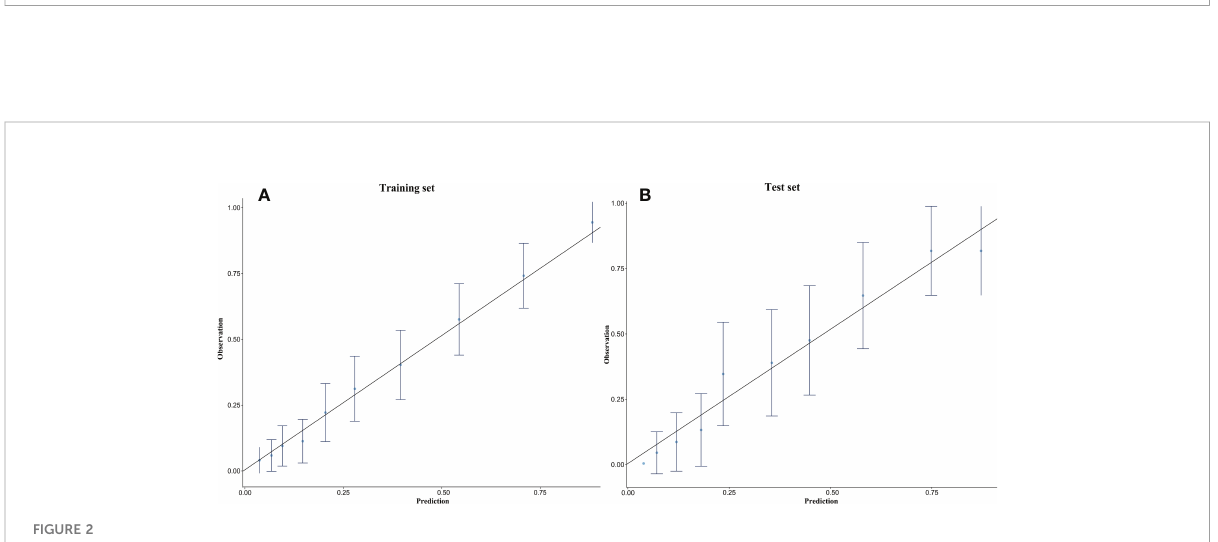
FIGURE 2 Calibration curves of the XGBoost model in the training set (A) and the test set (B)